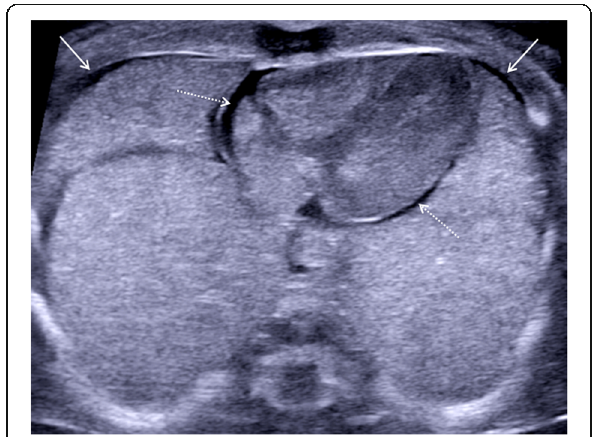
Fig. 8 Transverse postmortem ultrasound image through the chest in a 19-week gestational-aged foetus, obtained 8 days after death showing normal postmortem fluid accumulation within the pleural spaces (solid white arrows) and pericardium (dotted arrows) bilaterally. These are commonly seen and described as ‘ postmortem changes ’ and should not alarm the ultrasound operator